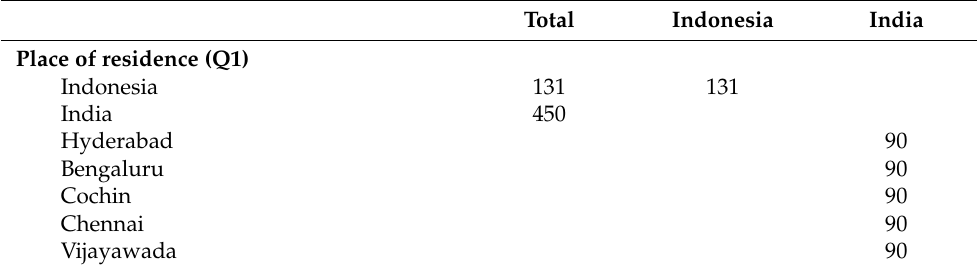
Table 5. Descriptive statistics for Q1 to